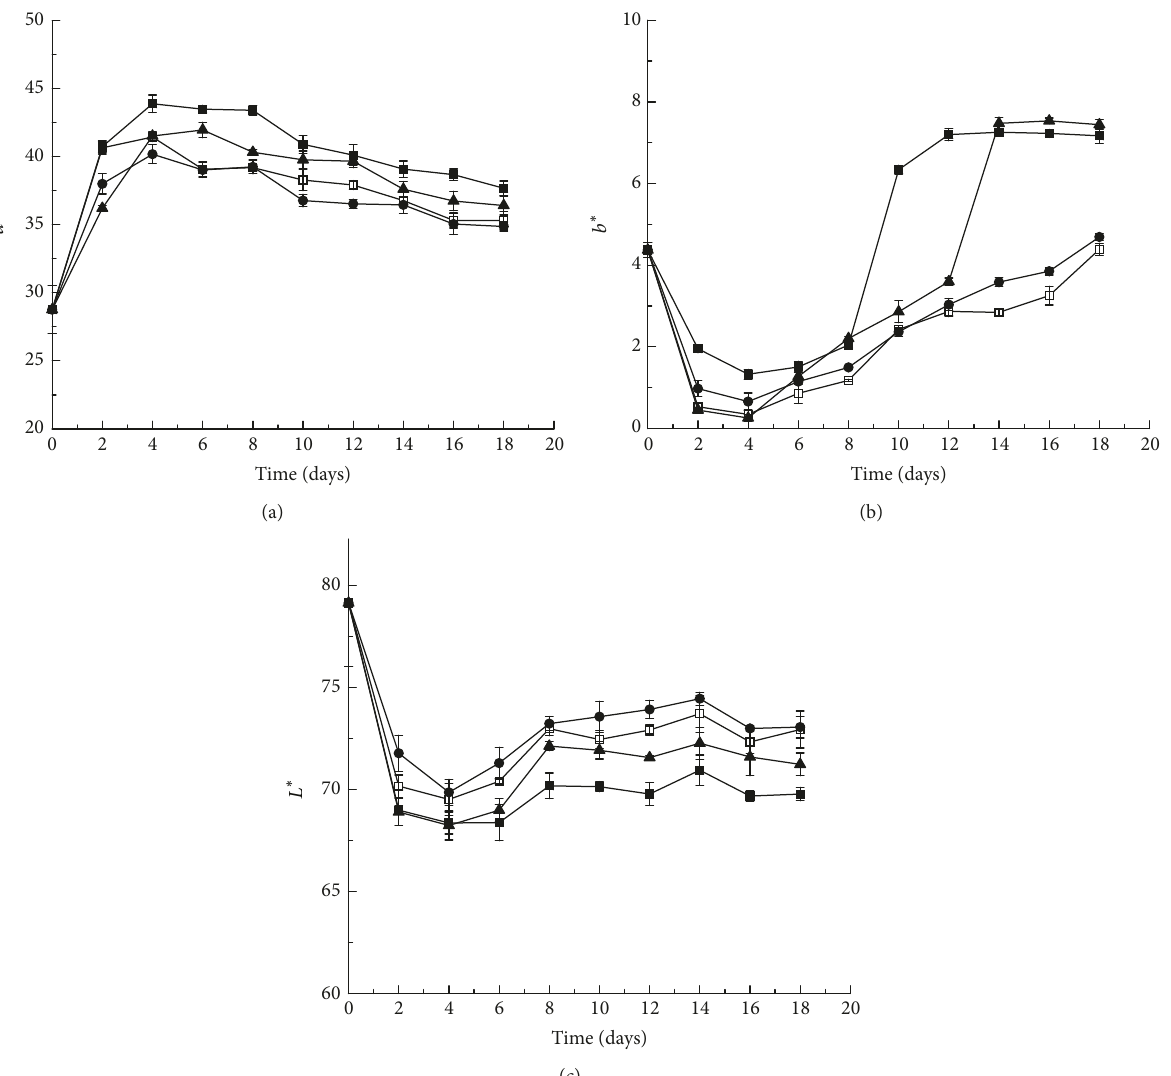
Figure 3: Changes of the color parameters including: 𝑎 ∗ (red/green, (a)), 𝑏 ∗ (yellow/blue, (b)), and 𝐿 ∗ (lightness, (c)) of “Shuangyou” wines added with 20 ( e ), 60 ( ◼ ), and 100 ( 󳵳 ) g/L sucrose and controls ( ◻ ) during